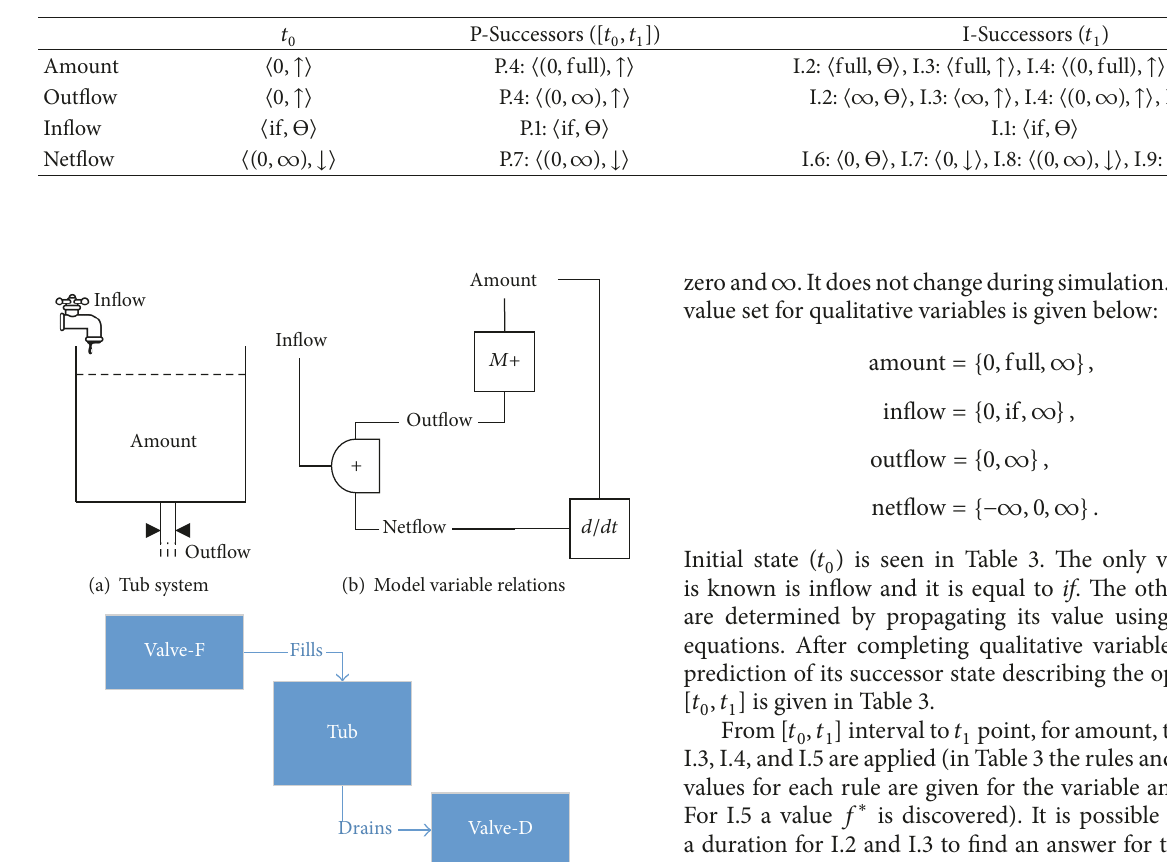
Table 3: Qualitative behavior trajectory for Case 1.